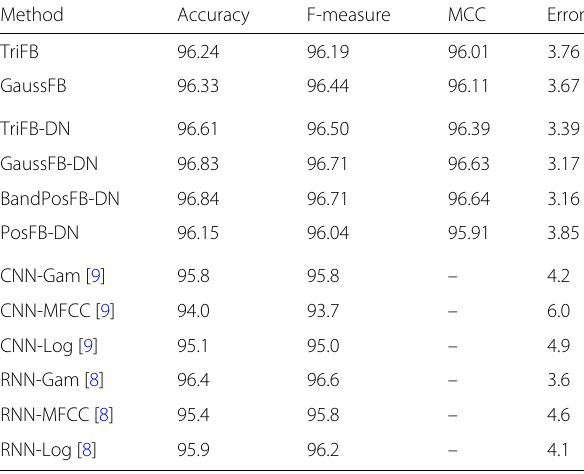
Table 5 Performance comparison on LITIS ROUEN